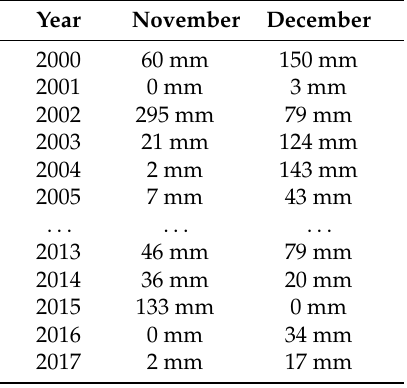
Figure 1. Location of study area and subset depicted in Figure 2. Table 1. Monthly precipitation for Mzuzu (Malawi) in different